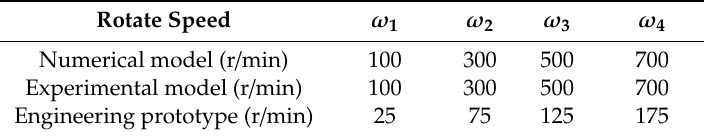
Table 2. The parameter selection of rotate speed.